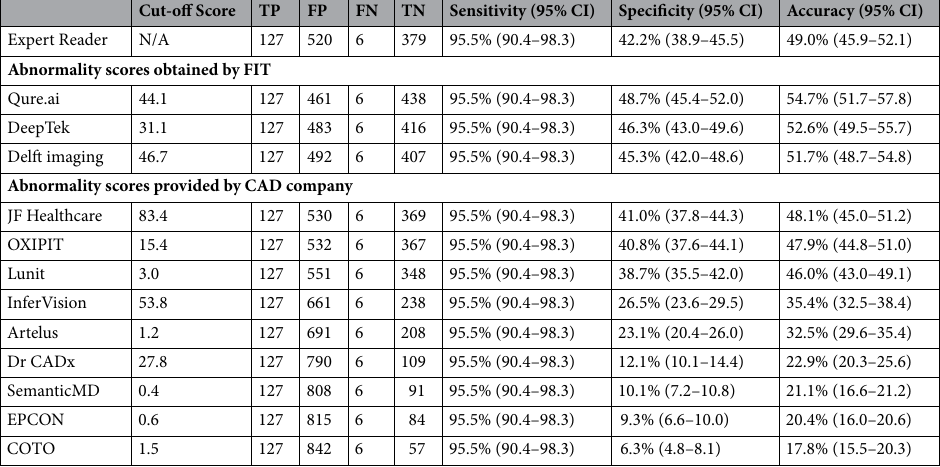
Table 3. CAD software performance when matching the sensitivity of the Expert Reader. TP true positive, FP false positive, FN false negative, TN true negative.